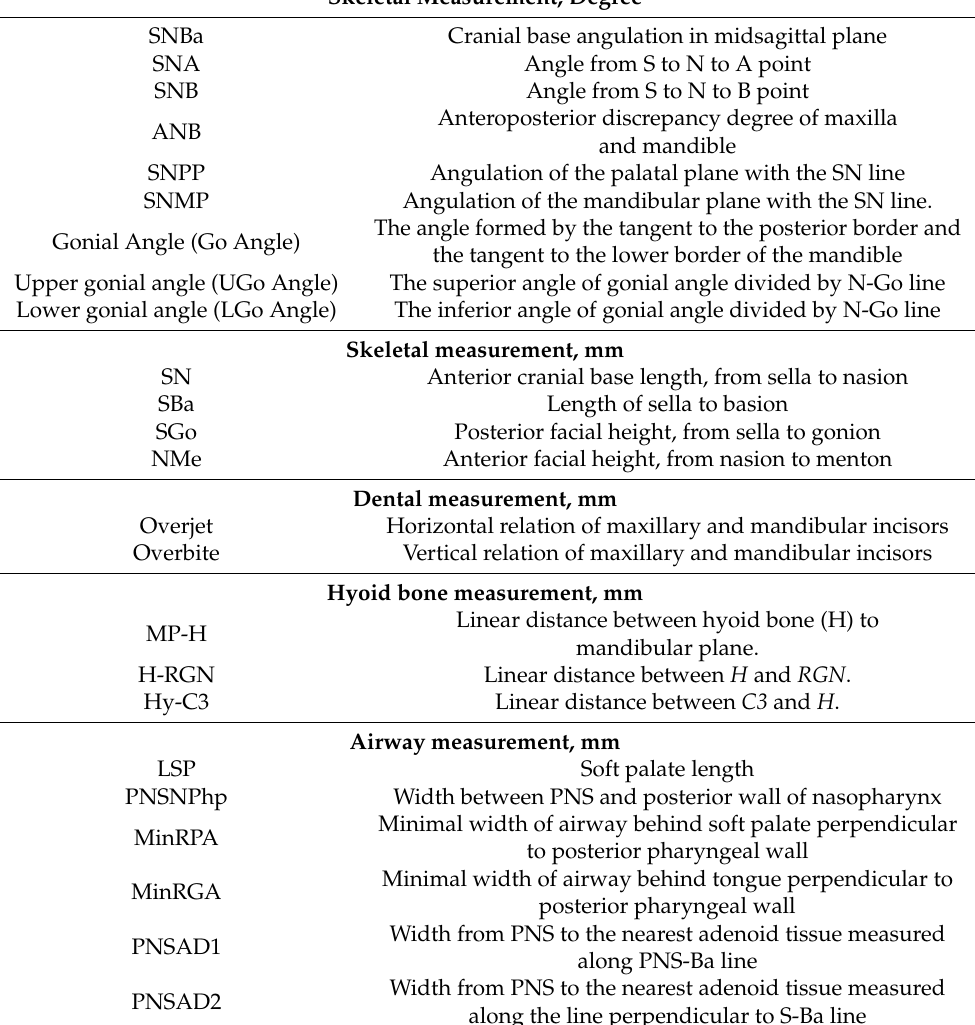
Table 2. Cephalometric analysis: variables and definitions. Skeletal Measurement,